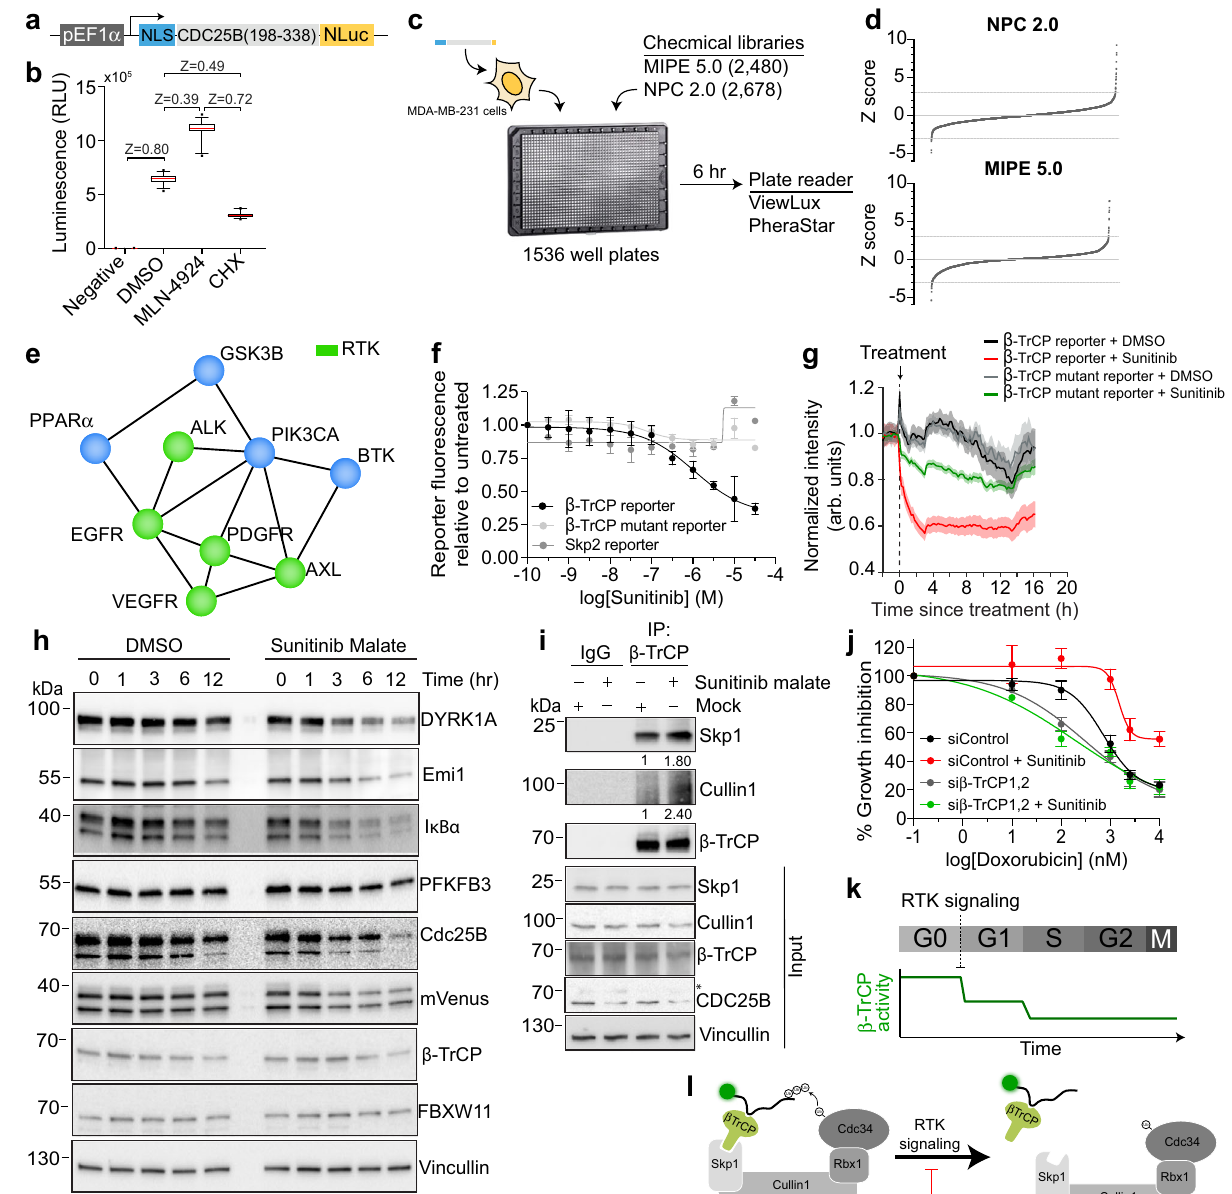
Fig. 5 | High-throughput screening approach using the β -TrCP reporter. a Schematic showing the β -TrCP reporter fused to NanoLuc luciferase (NLuc). b Relative luciferase activity of MDA-MB-231 cells stably expressing β -TrCP reporter treated with DMSO, MLN-4924, or cycloheximide (CHX) for 6h. Graph is a box-and- whiskerplotwhere thered line representsthe median,the boxrepresentsthe inter- quartile range, and the whiskers represent 5 – 95 percentiles. Dots represent indivi- dualdatapoints beyond these percentiles. n =32 replicates. c Work fl ow of the high- throughput screening (HTS) strategy. MDA-MB-231 cells stably expressing the β - TrCP-NLucreporterwereseededin1536-wellplates.TheinitialscreenusedtheMIPE 5.0,andNPC2.0librariescomprisingover5000approvedandinvestigationaldrugs. After 6h of treatment, luminescence was measured using a PHERAstar FSX micro- plate reader (BMG Labtech). d Scatter plot summarizing luminescence of MDA-MB- 231 cells expressing β -TrCP-NLuc reporter treated with compounds from MIPE 5.0 and NPC 2.0 library as described in ( c ) Each dot represents the percent activity of eachsmall-moleculecompoundtestednormalizedtoneutralandnegativecontrols. Shaded regions highlight compounds demonstrating greater than 50% change relative to DMSO-treated controls. e STRING pathway analysis of proteins whose inhibitors were found to activate β -TrCP activity in our screen. Nodes were colored green if they are a receptor-tyrosine kinase (RTK). f Relative reporter levels of